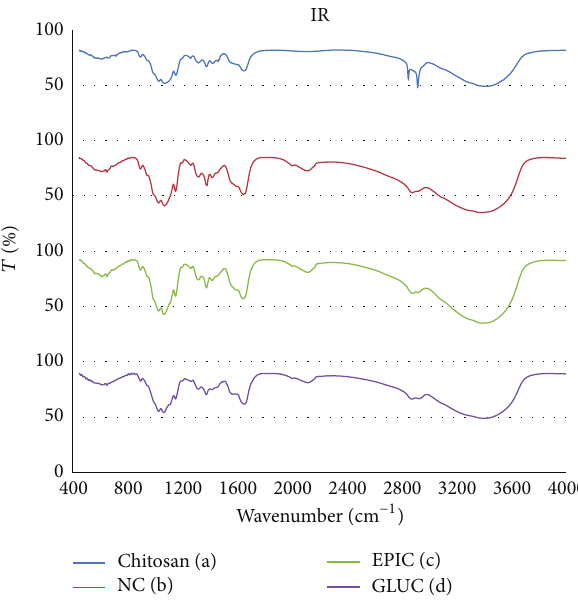
Figure 6: FT-IR spectra of (a) chitosan, (b) catalyst loaded chitos- an without cross-linking, (c) epichlorohydrin cross-linked chitos- an/catalyst composite, and (d) glutaraldehyde cross-linked chitos- an/catalyst